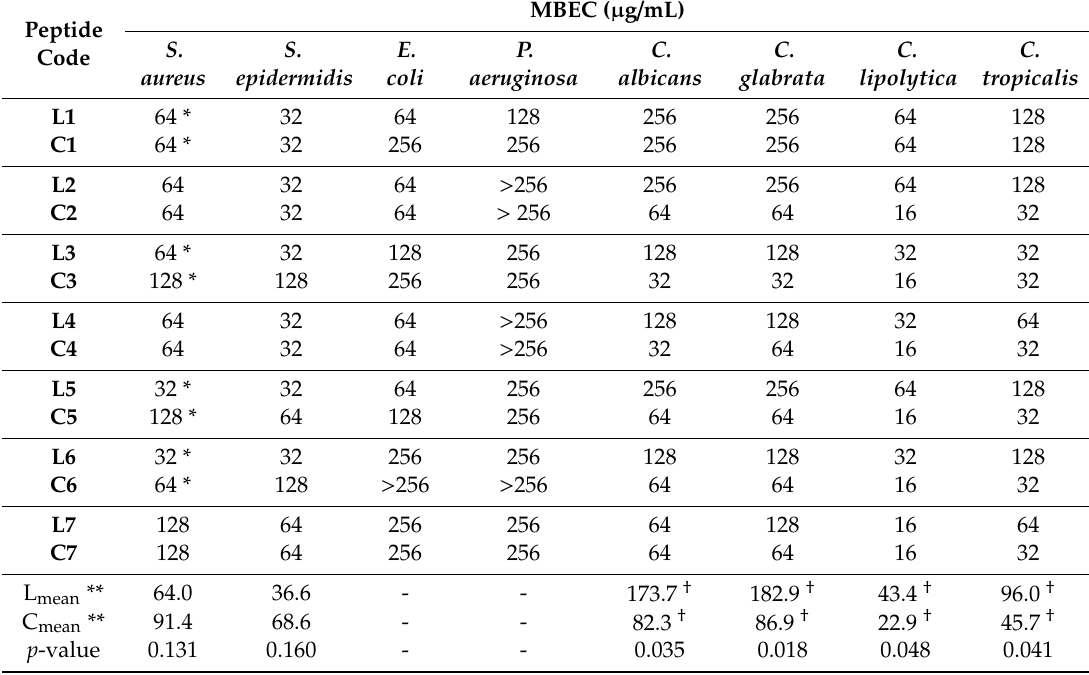
Table 3. Antibiofilm activity of lipopeptides.